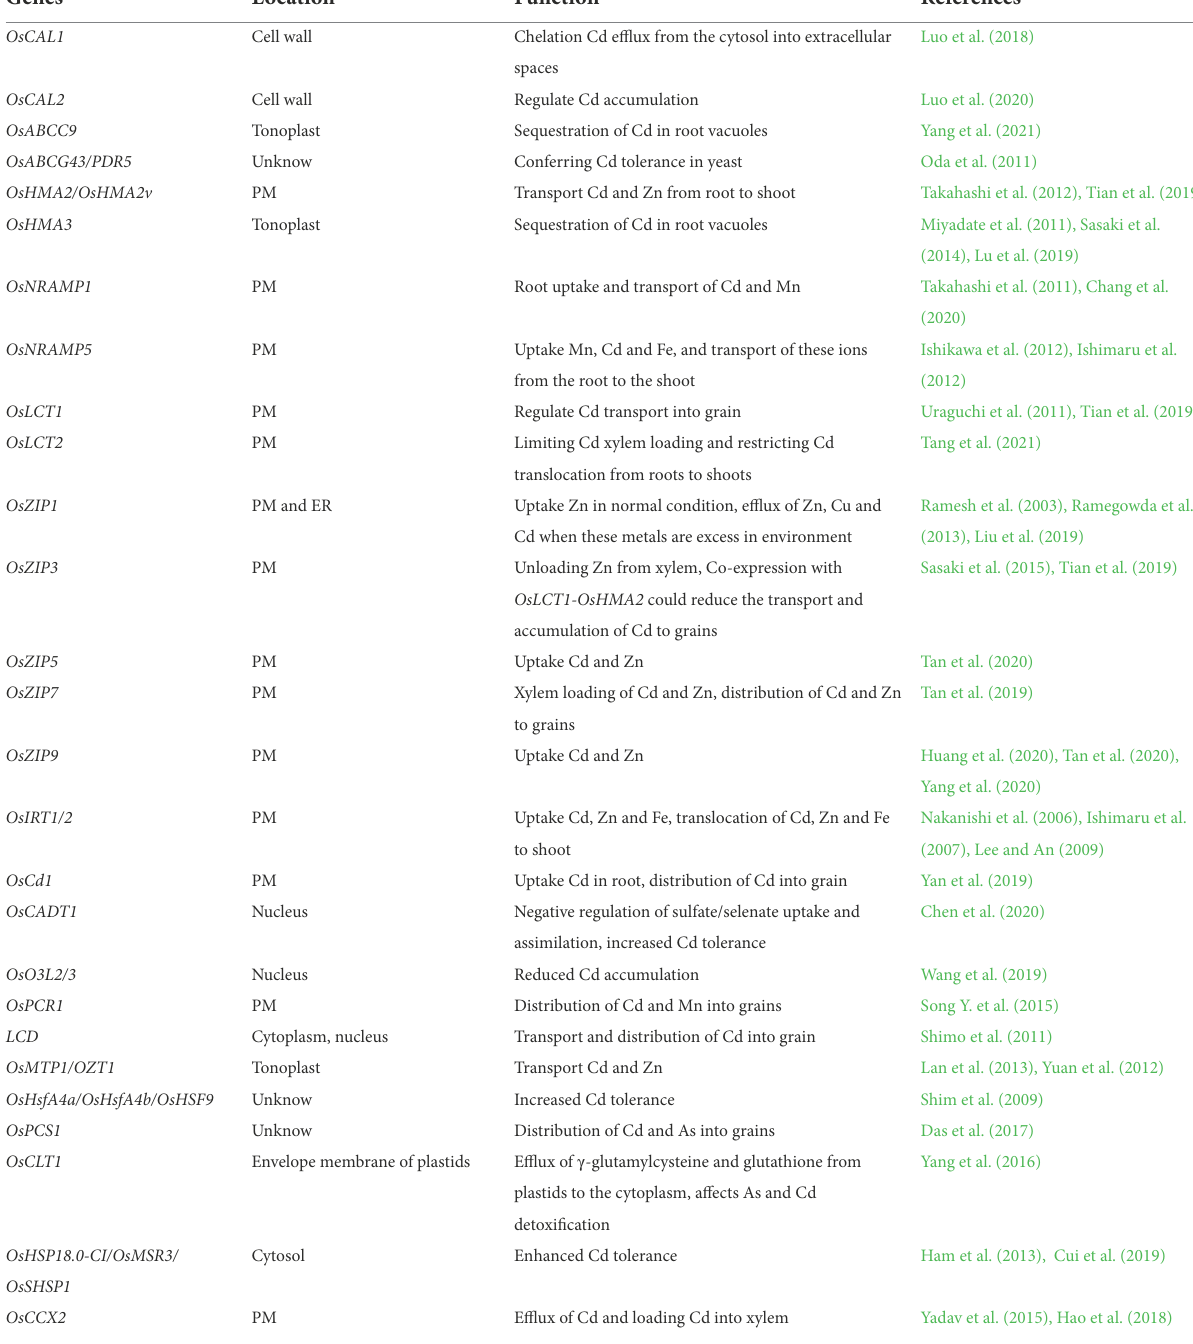
TABLE 1 Genes involved in Cd uptake and transport in